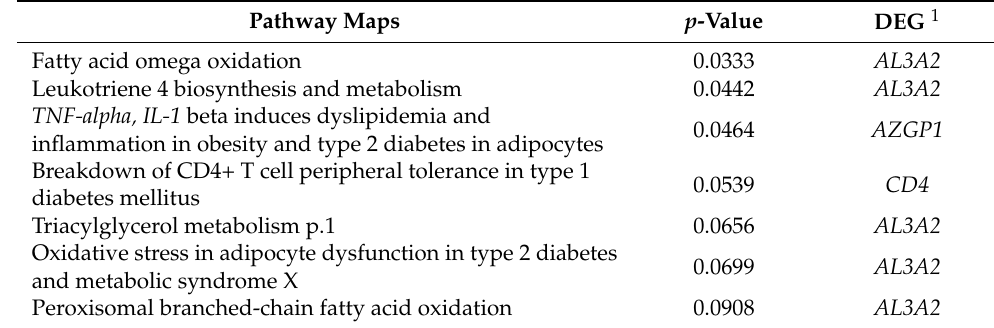
Table 4. Pathway maps identified by MetaCore software ( p -value < 0.10) from the list of differentially expressed genes (FDR 10%) in the skeletal muscle of pigs fed with two different levels of soybean oil in the